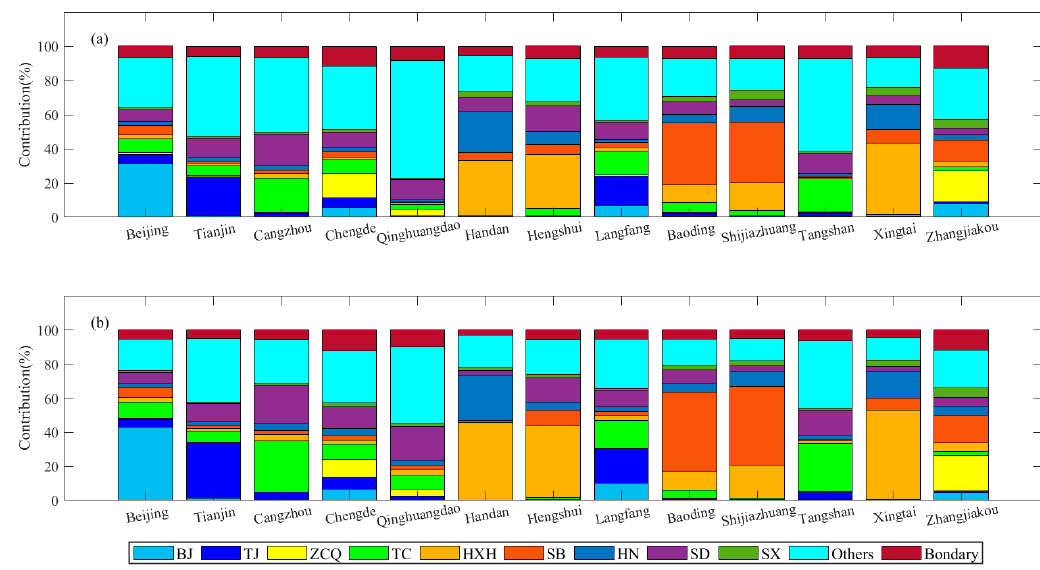
Figure 7. O 3 spatial source apportionments by source regions in cities on the NCP ( a ) monthly average results; ( b ) during O 3 episodes.